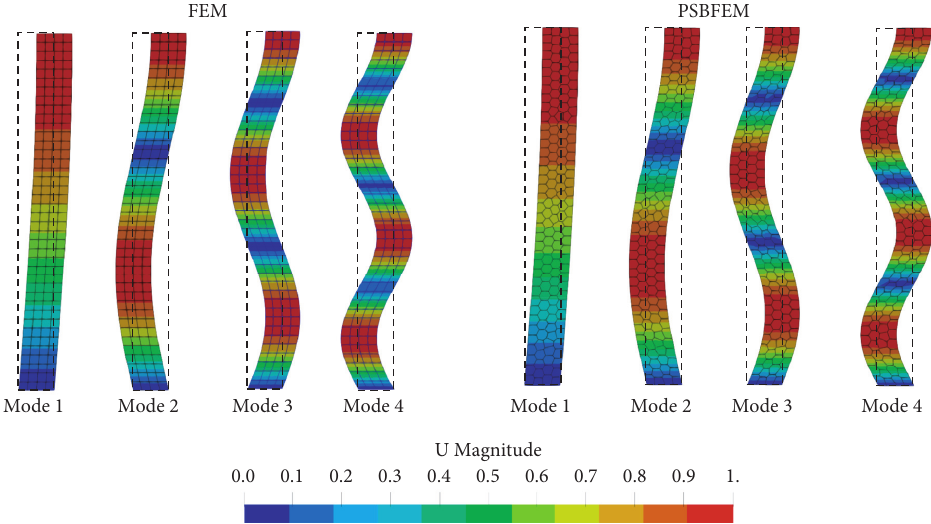
Figure 6: First four mode shapes of the horizontal soil foundation. (a) FEM. (b)